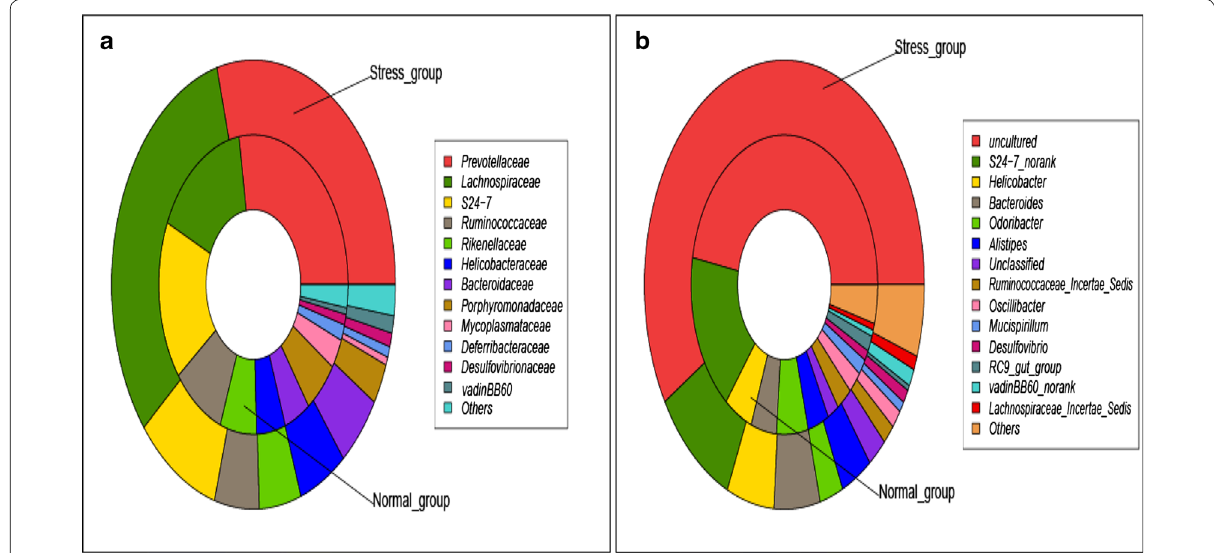
Fig. 3 Taxonomic composition. a The taxonomic composition diagram at the family level, and b taxonomic composition diagram at the genus level